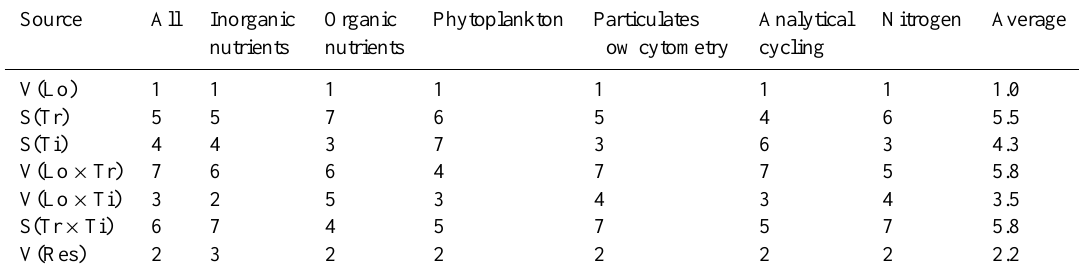
Table 5. Ranked estimates of components of variation for permutation-based analysis of variance tests. Details of the parameters included in parameter groups are provided in Table 2. Lo – location, Tr – treatment, Ti – time, Res – residual. “Average” indicates the average rank across groups of variables excluding the ranks for all